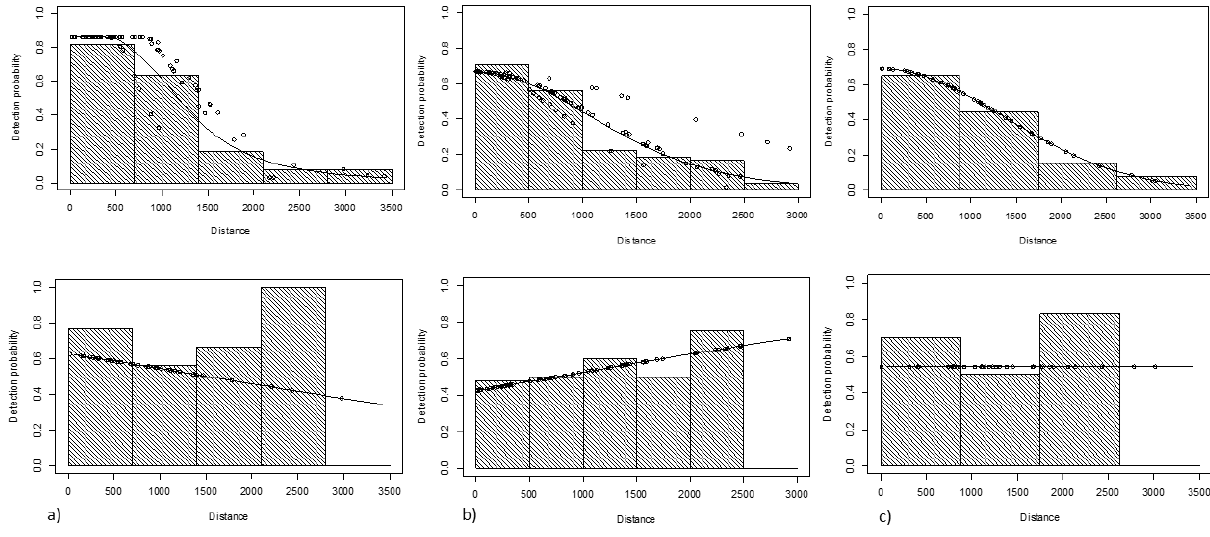
Figure 15. Detection function curves for pooled detections (top) and the conditional detection probabilities of platform 1 (bottom) for the NASS extension survey in 2015 for (a) fin whales, (b) humpback whales, and (c) sperm whales.